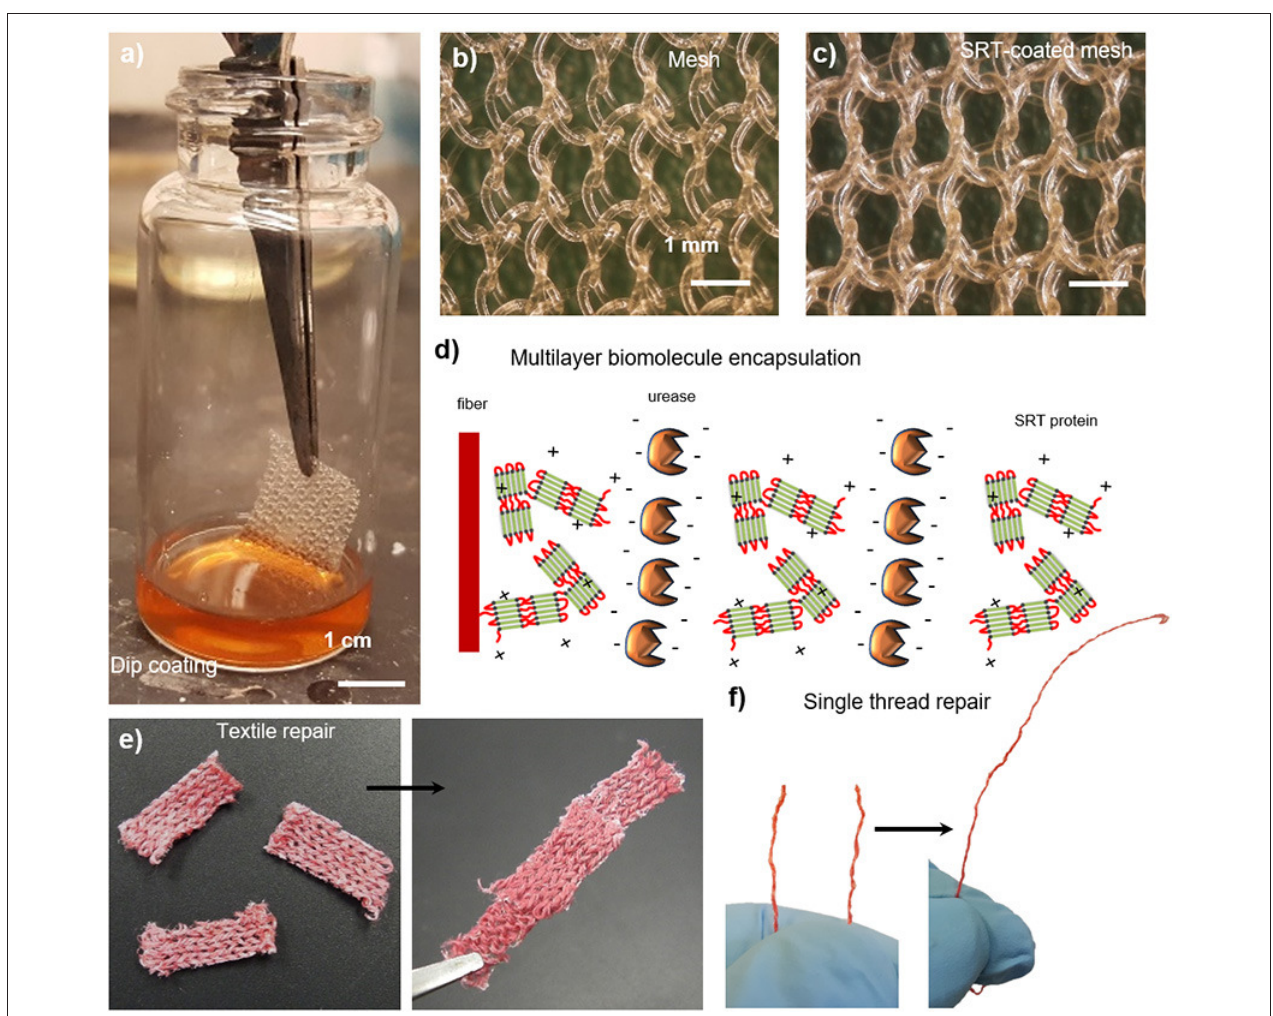
FIGURE 6 | SRT protein films for smart repairable textiles. (a) Natural and synthetic fabrics are coated with SRT protein. (b) Pre-coating and (c) post-coating images show a homogeneous coating around individual polypropylene fibers. Reproduced with permission ( Leberfinger et al., 2018). (d) Multilayer biomolecule encapsulation (enzymes), providing built-in detection and protection against hazardous agents. Self-healing and repairable (e) fabrics and (f) single fiber maintain the activity of encapsulated biomolecules. Reproduced with permission ( Gaddes et al., 2016). Copyright 2016 American Chemical